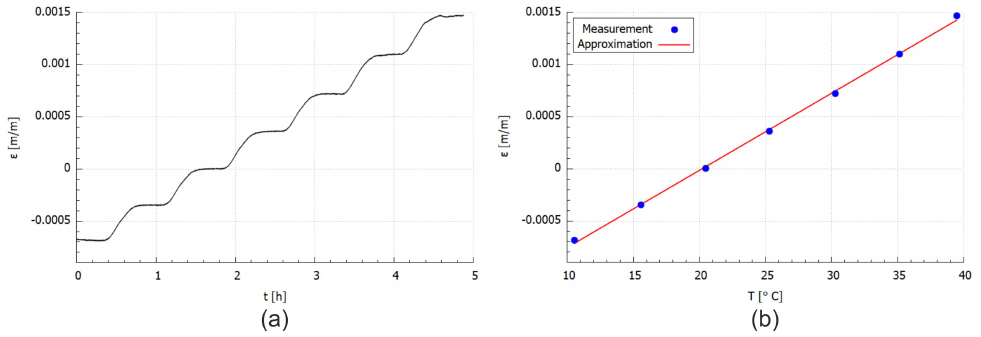
Figure 9. Experimental investigation results for PLA: ( a ) Material strain, ( b ) relationship between the material strain and temperature.